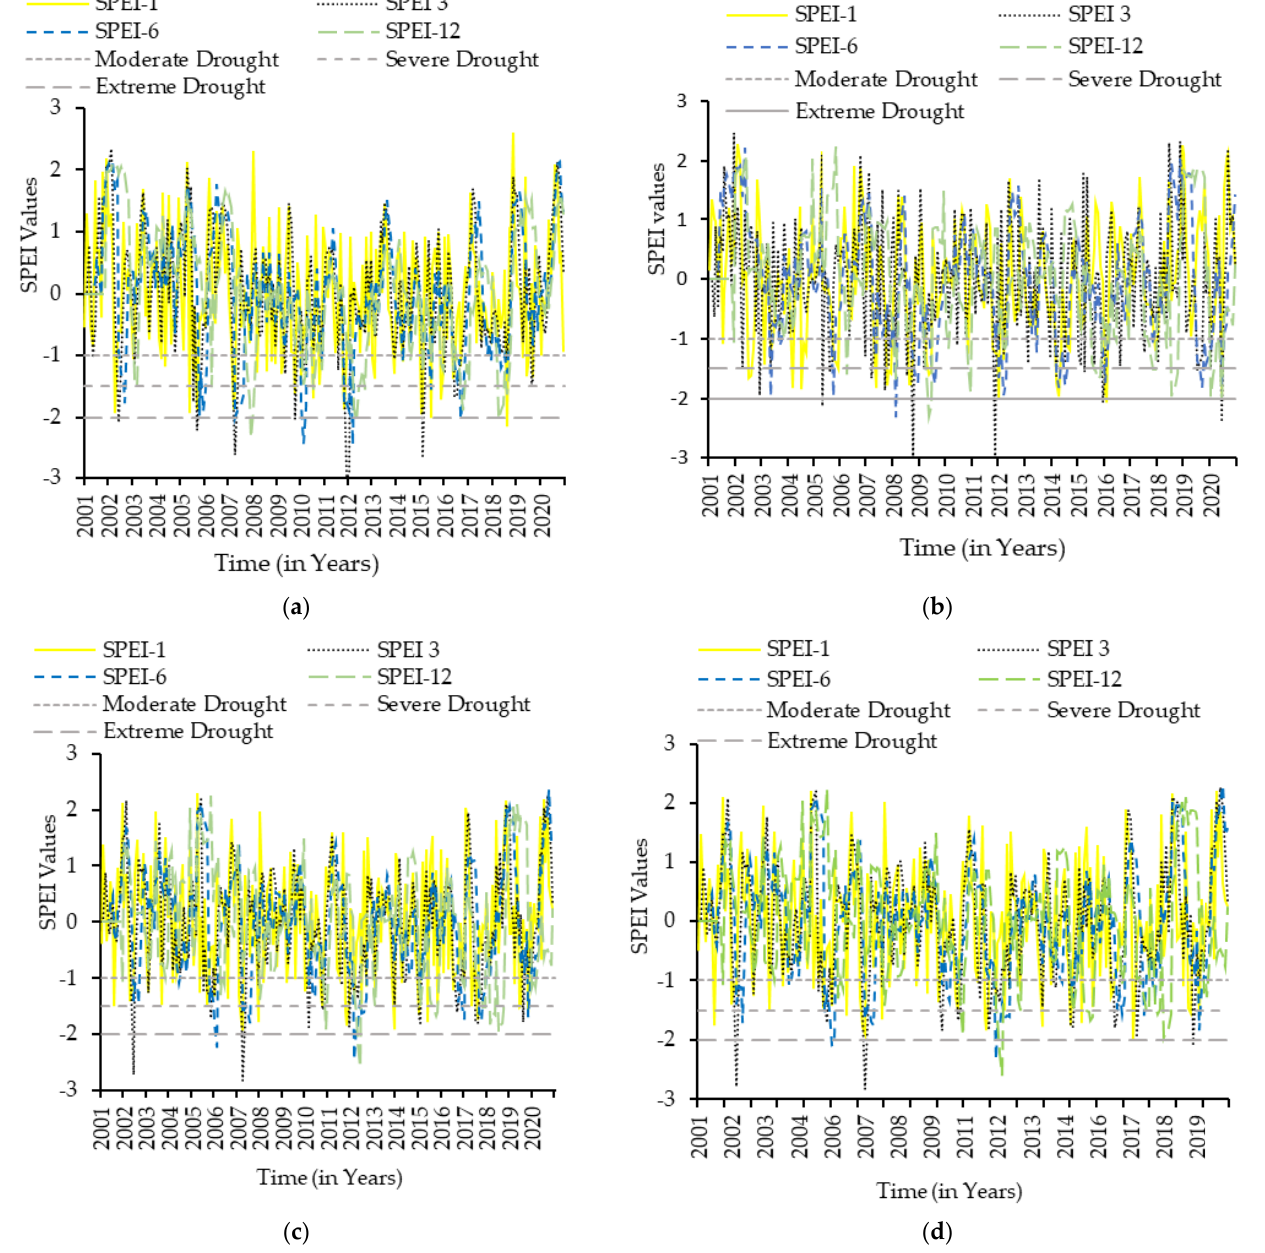
Figure 3 . Time series analysis at four stations of the AlLith watershed on different time scales of SPEI (1-, 3-, 6-, and 12-month) at ( a ) J107, ( b ) J108, ( c ) TA109, and ( d )